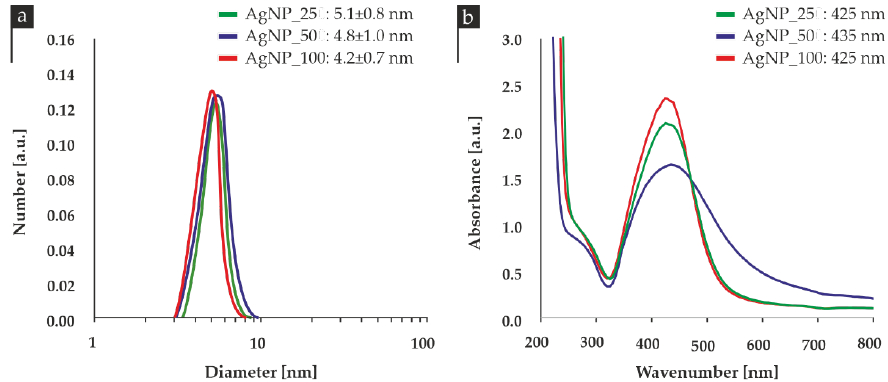
Figure 1. ( a ) Particle size distribution and ( b ) UV-Vis spectra of all three AgNPs samples.